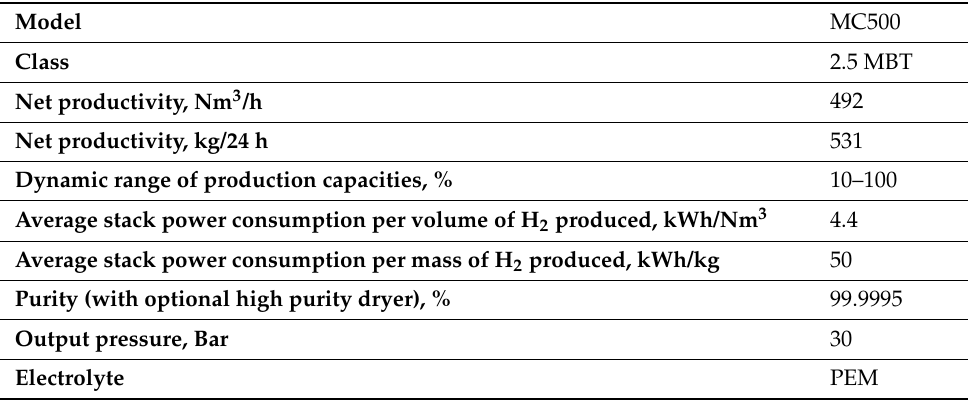
Table 8. Specifications of the electrolysis